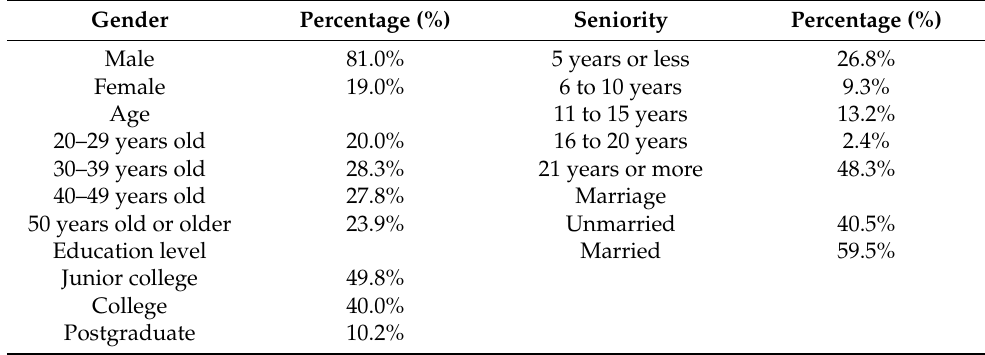
Table 1. Sample basic